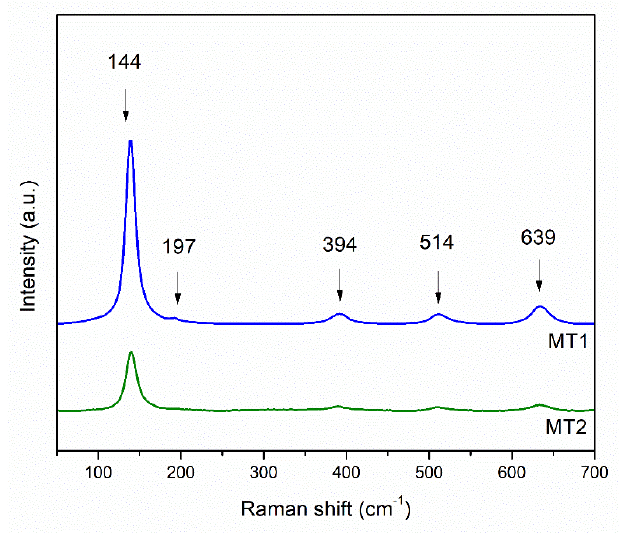
Figure 2. Raman spectra of material (MT1) and MT2 samples.